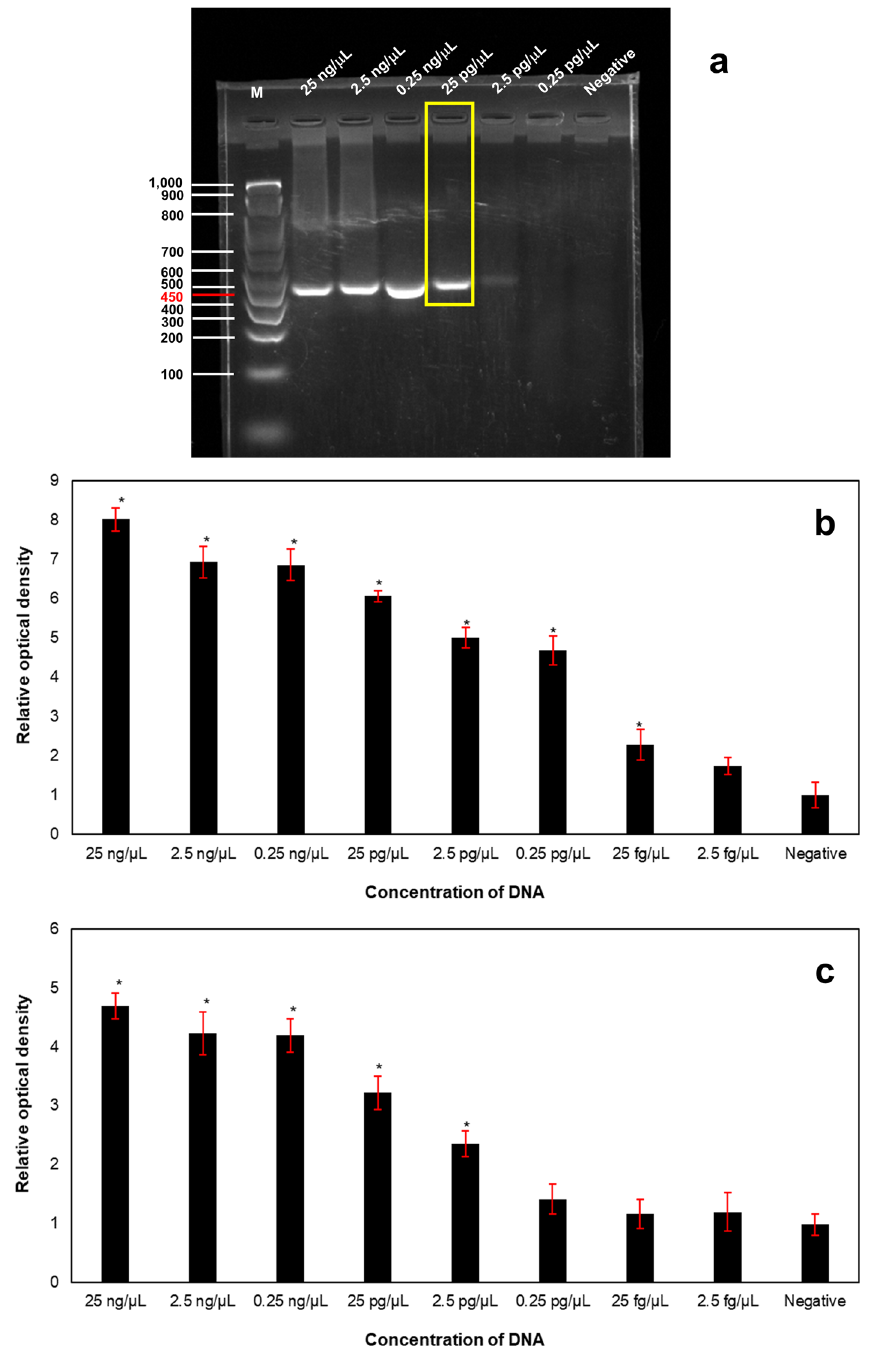
Figure 7. Evaluation of the detection limit for detecting the LT gene using conventional PCR ( a ), MELGA ( b ) and SSNP-enhanced PCR assays ( c ). Original gel of conventional PCR is presented in Supplementary Fig.